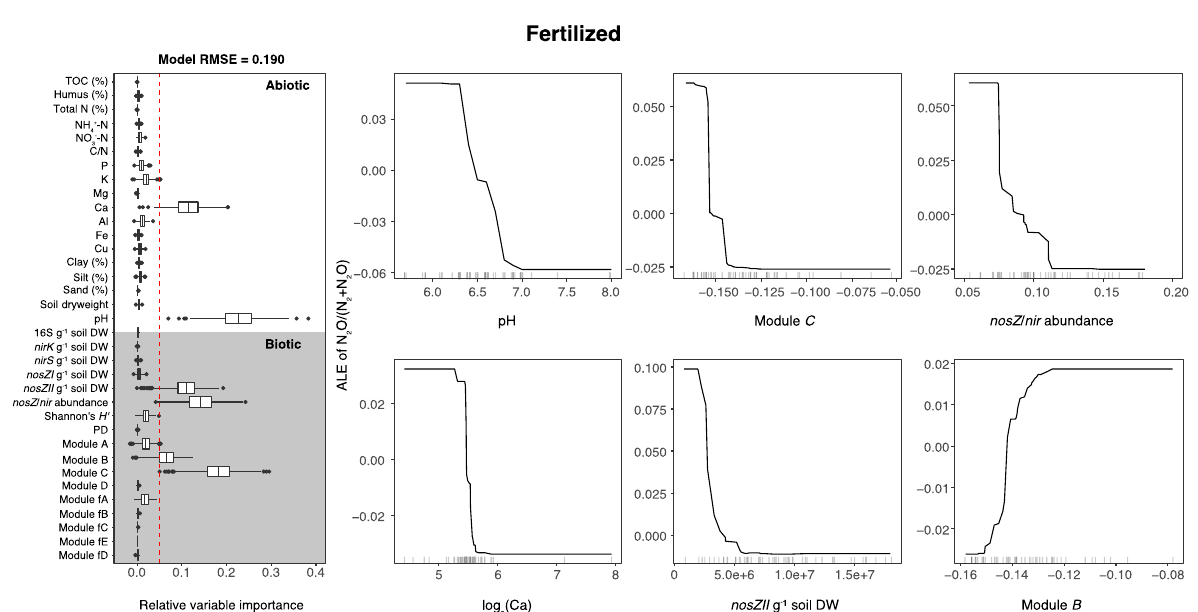
Methods Soil sampling and analyses of soil properties . Soil samples were taken in October and November 2013 from 14 long-term fi eld trials located in different regions across Sweden (Supplementary Table 1). Each fi eld trial included unferti- lized and mineral fertilization treatments ranging from 80 – 150 kgN ha − 1 year − 1 that have been managed for a minimum of 15 up to 57 years under annual cereal crop rotations. All trials consisted of 2 – 6 fi eld replicates per treatment, and soil was collected from each replicate plot for a total of 108 samples. For each sample, fi ve cores from the topsoil (0 – 20 cm) were taken from each fi eld plot, then